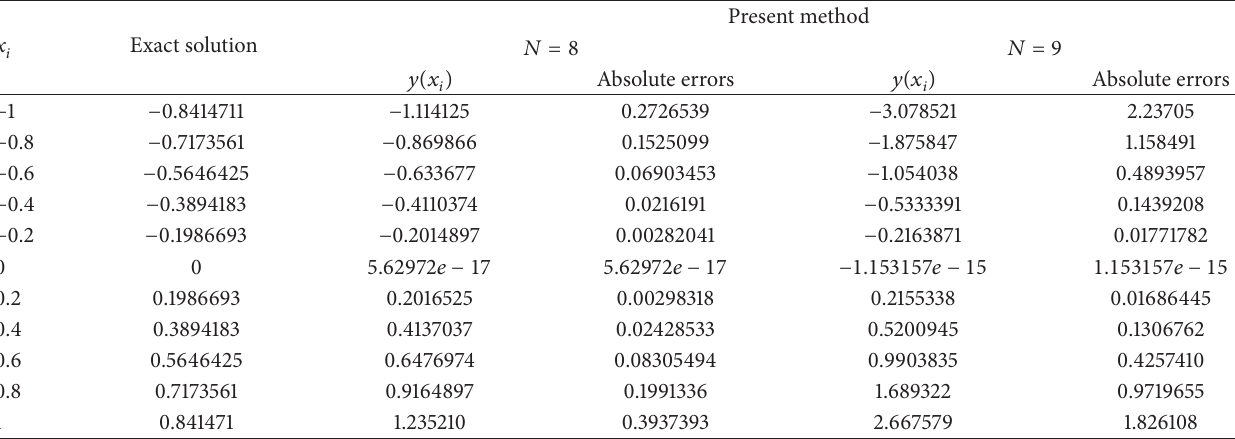
Table 1: Comparison of the absolute errors of Example 2.